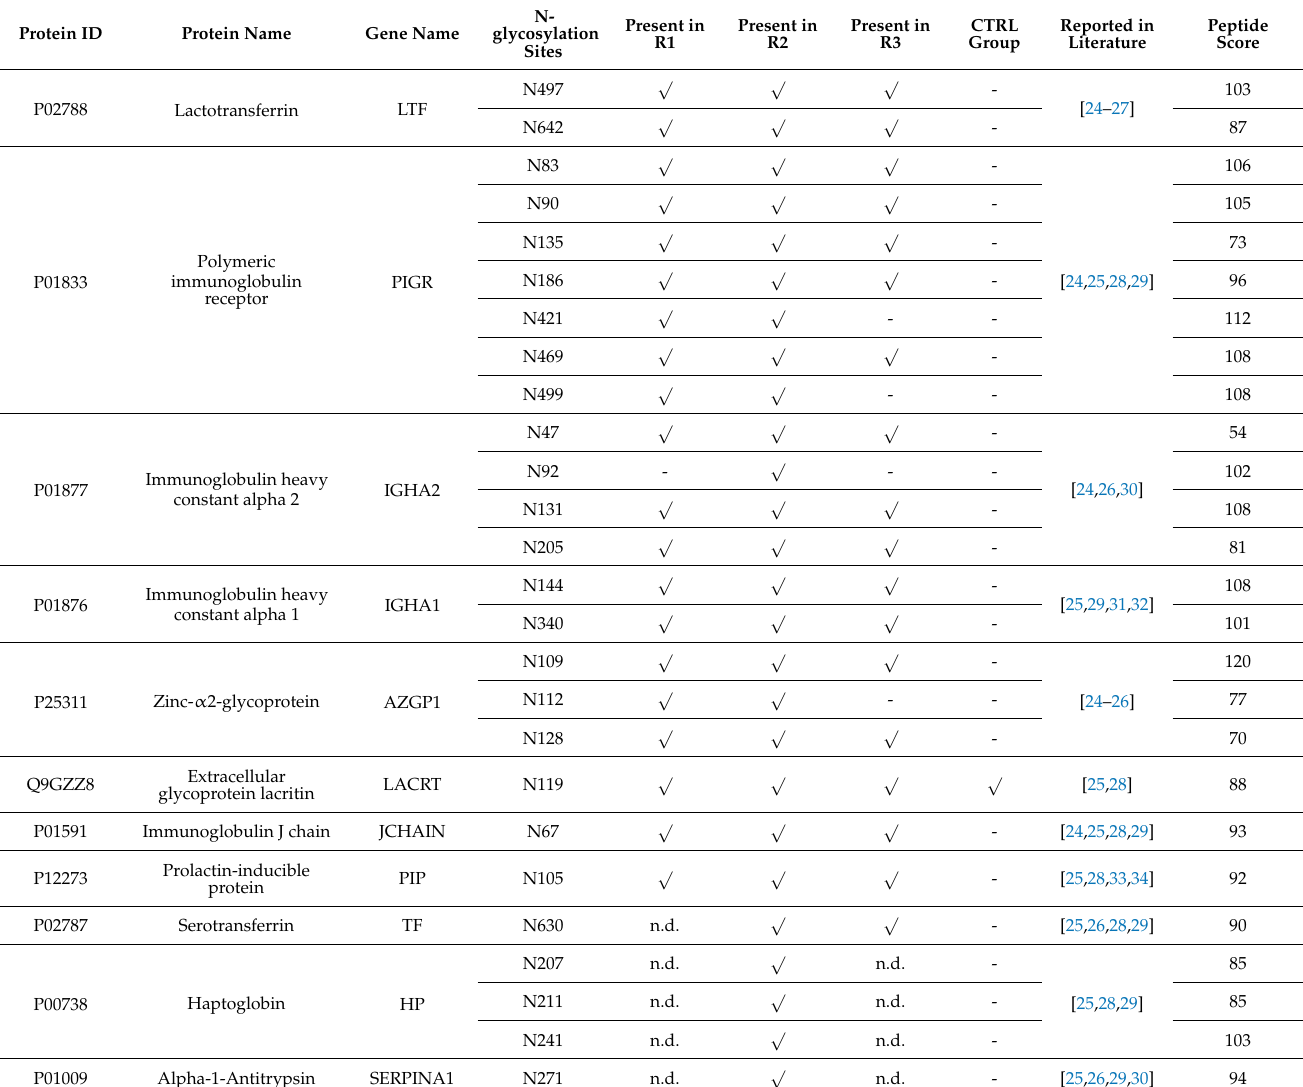
Table 1. Glycoproteins and their N-glycosylation sites in the human tear sample pools of healthy